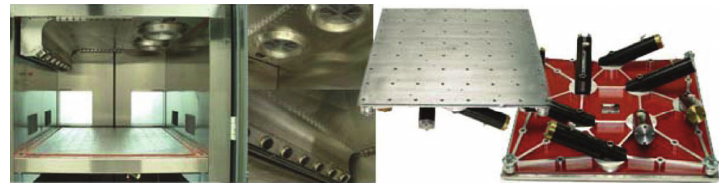
Figure 5: High accelerated life testing (HALT) chamber [15].